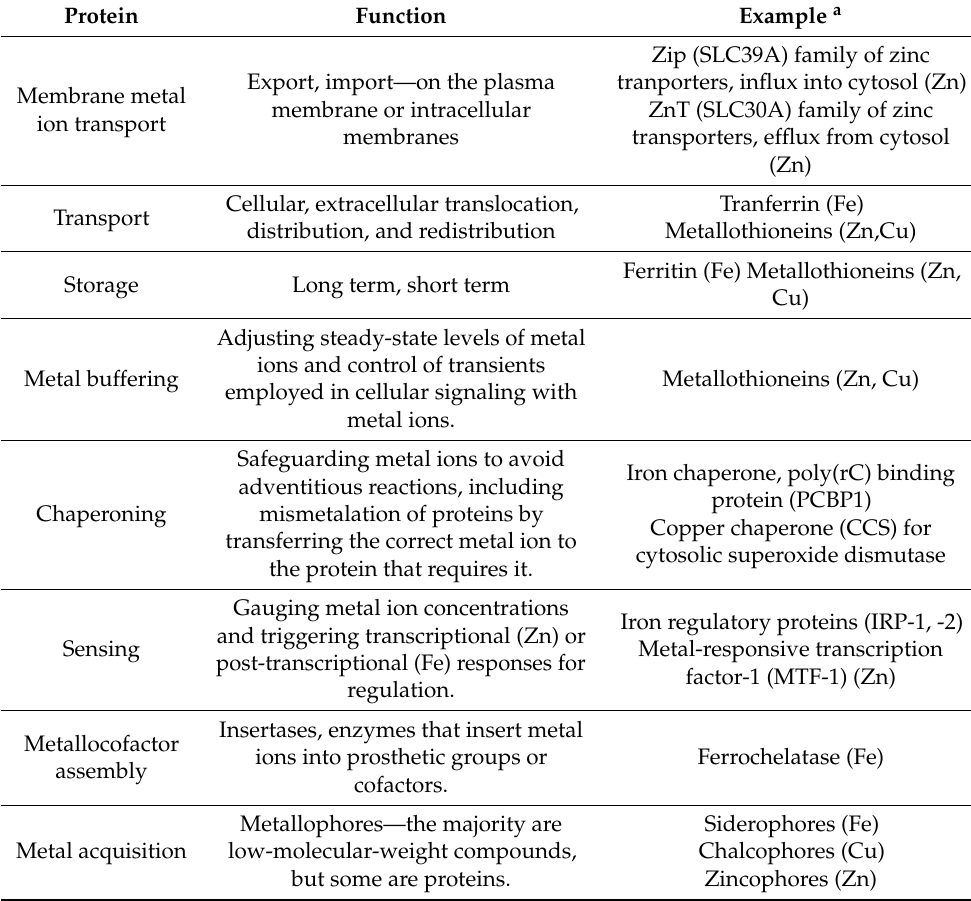
Table 1. Functions of homeostatic proteins of metal